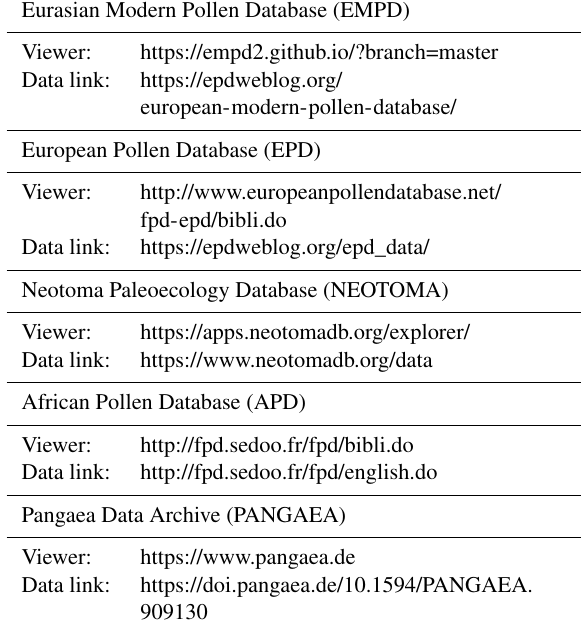
Table 3. Web addresses for pollen databases mentioned in the